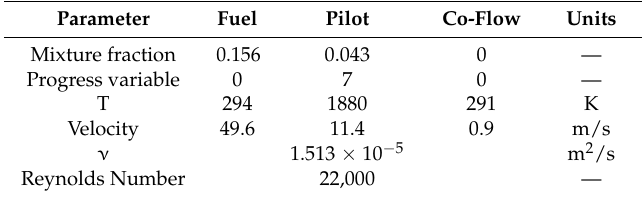
Figure 2. Sandia Flame-D configuration, ( a ) Description of the piloted CH4/Air jet FlameD ( b ) A 2D numerical block structured Grid. Table 1. Description of the initial/boundary numerical conditions for piloted jet